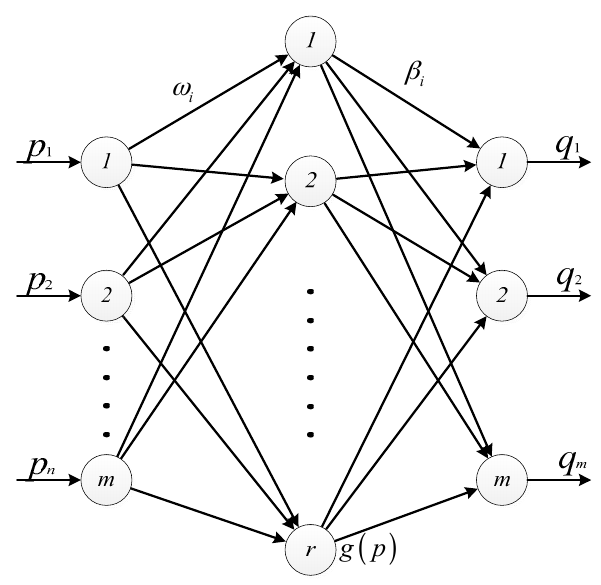
Figure 3. The schematic diagram of ELM.